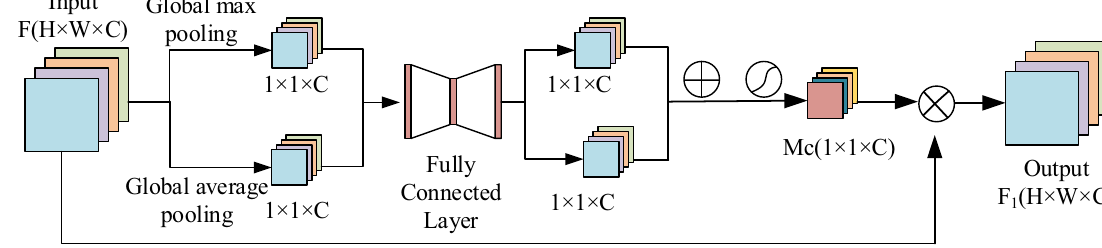
Figure 2. Channel attention module.